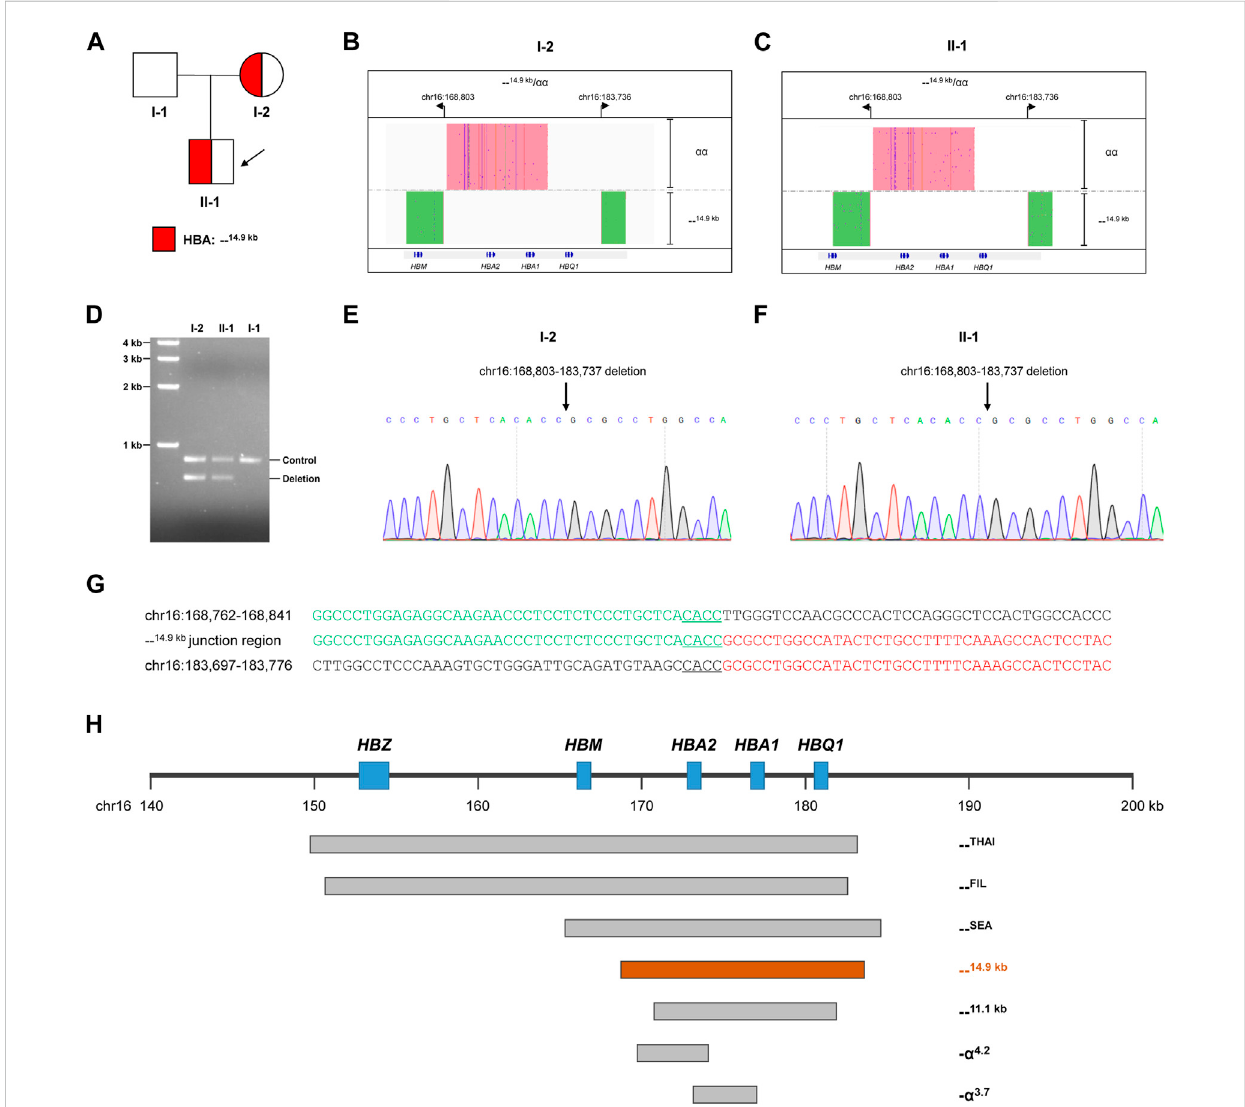
FIGURE 1 Thalassemiagenetic testing byLRS technology. (A) Pedigreeof thefamily. (B, C) Integrative Genomics Viewer plot displayed the CCS readsof SMRT sequencing for the proband ( Ⅱ -1) and mother (I-2). The pink area showed the αα allele, and the green area showed the other allele with 14.9-kb deletion. (D) Validation of the large deletion by gap-PCR. The primers were designed fl anking hg38 chr16:168803-183737 to detect the 14.9-kb deletion. (E,F) Con fi rmation of the exact breakpoints of deletions by Sanger sequencing for the proband (II-1) and mother (I-2). (G) Sequence of breakpoint junctions of the 14.9-kb deletion. Reference sequences encompassing the breakpoints were shown above and below the sequences with deletion. The sequences withmicrohomology inthebreakpoint junctionswereunderlined. (H) Displayofthe14.9-kbdeletion inrelatedtootherrecurrentdeletionsin the α -globin gene